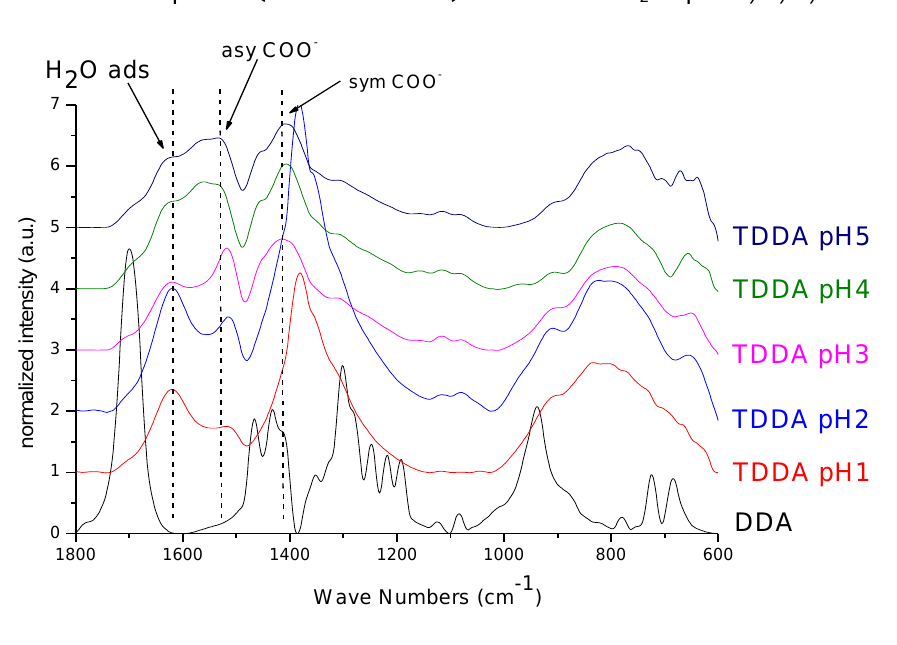
Figure 6. Schematic representation of DDA@TiO